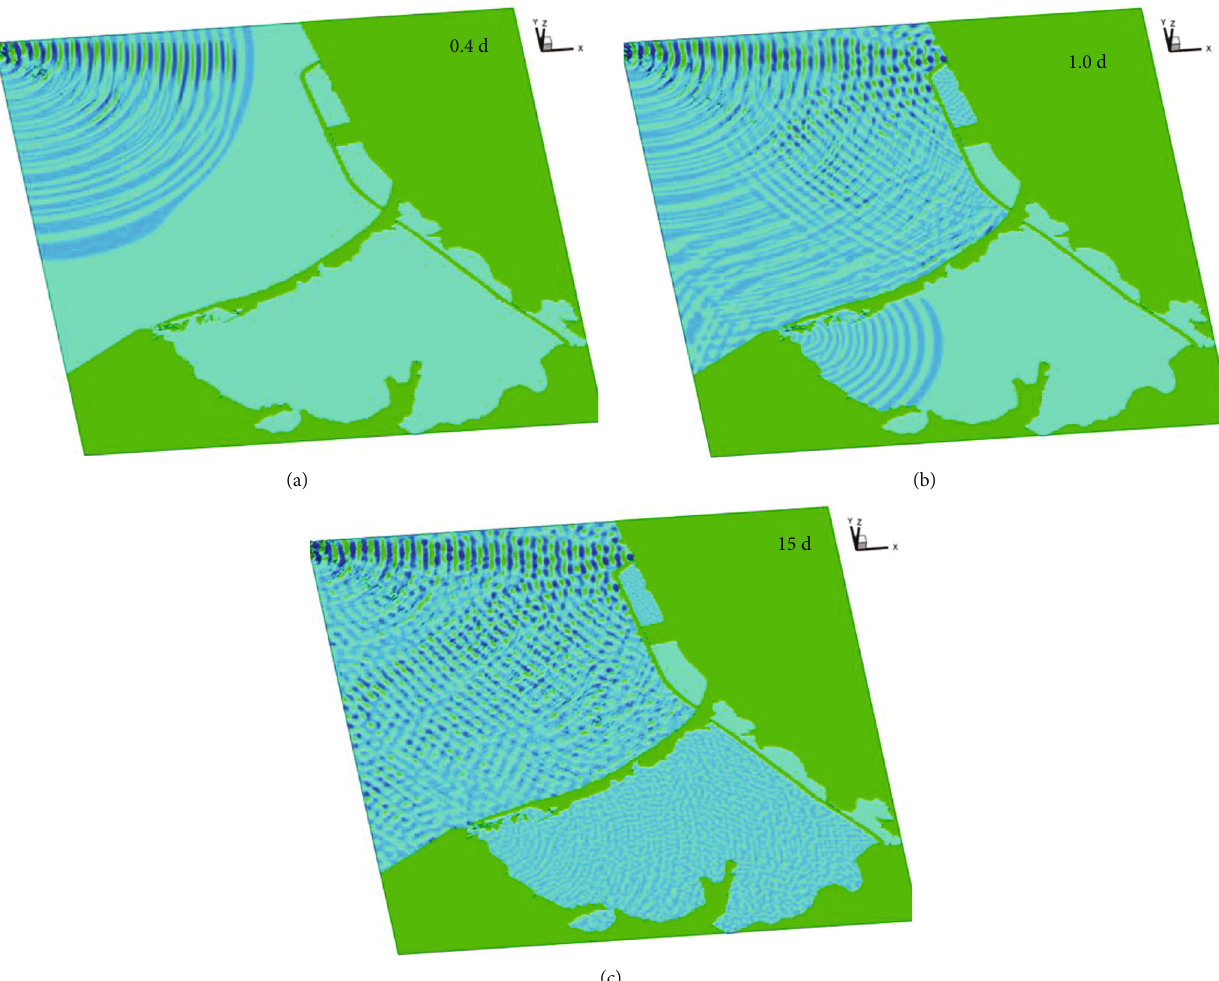
Figure 13: Development of wave propagation in the studied domain in extraordinary conditions with landward roadway: (a) 0.4 day (9.6 hour) simulation. (b) One day simulation. (c) Fifteen days